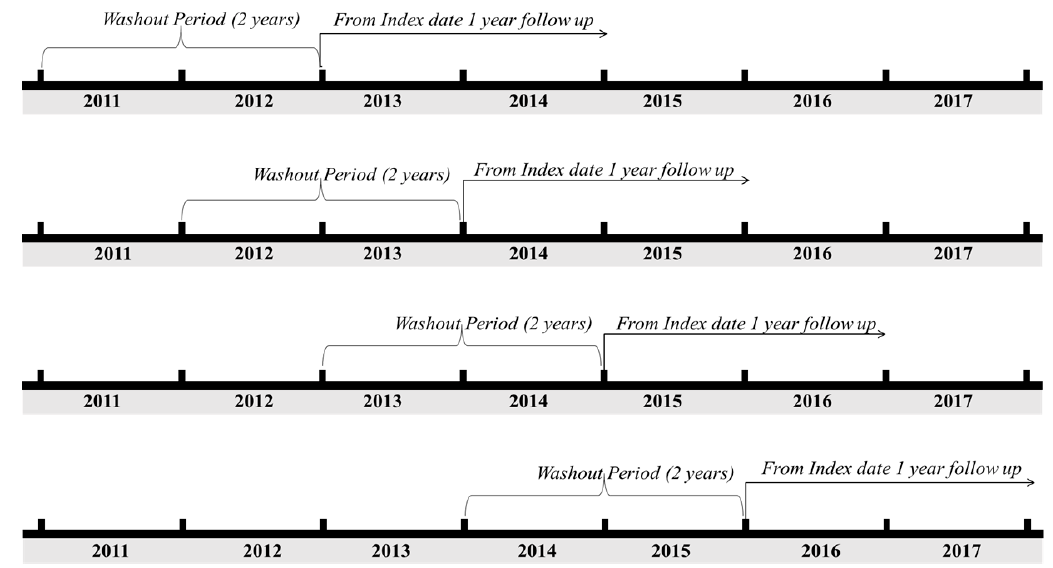
Figure 1. Study design of operational definition of new patients between 2013 and 2016.